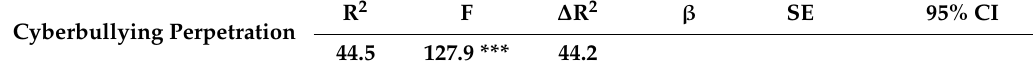
Table 3. Results of logistic regression for predicting cyberbullying